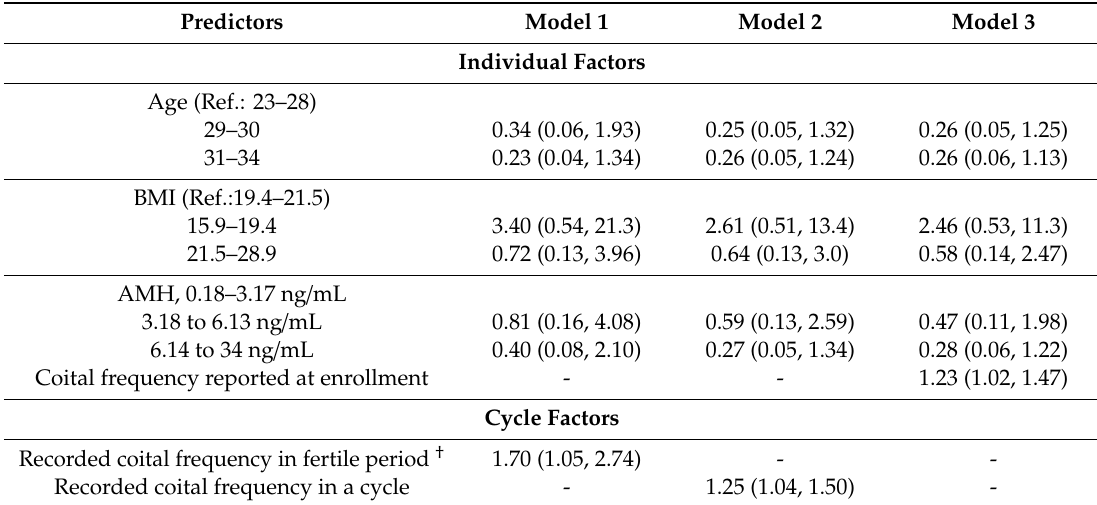
Table 2. Odds ratios and 95% confidence intervals for natural conception in 24-weeks of sample women from mixed e ff ect logistic regression models ( n = 319 cycles from n = 80